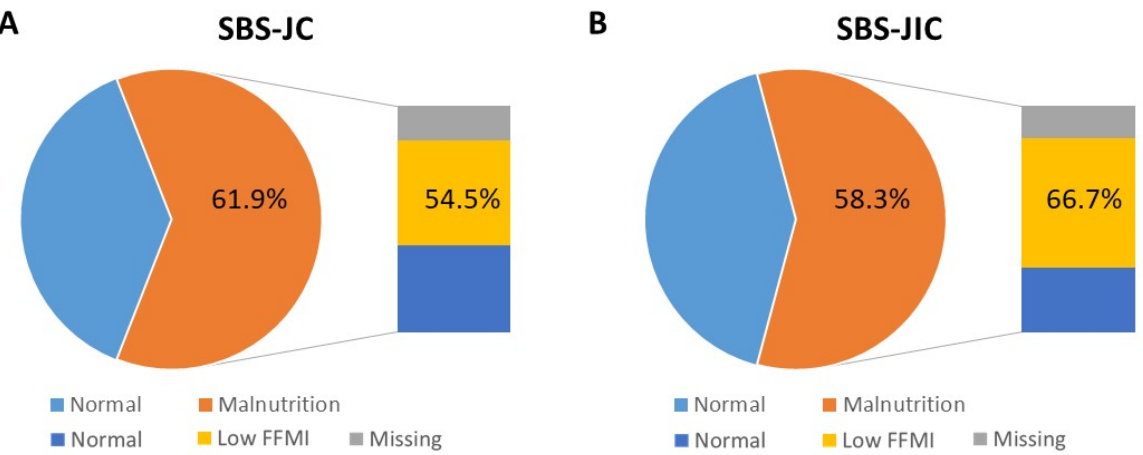
Figure 3. Prevalence of malnutrition in SBS-JC and SBS-JIC patients during FU after weaning. ( A ) SBS-JC and ( B ) SBS-JIC patients with malnutrition (GLIM-criteria), with prevalence of low muscle mass or FFMI in those with available BIA. Abbreviations: fat-free mass index (FFMI), short bowel syndrome (SBS), jejuno-colic anastomosis (SBS-JC), and jejuno-ileal anastomosis (SBS-JIC). In contrast, low muscle quality, or PA, was present in ten (55.6%) SBS-JC and three (27.3%) SBS-JIC patients. Interestingly, PA also decreased during FU ( ∆ = − 0.8 ( − 1.9; − 0.4), p = 0.03) and correlated with albumin (r = 0.6, p < 0.01) and FFMI (r = 0.58, p = 0.01) in the